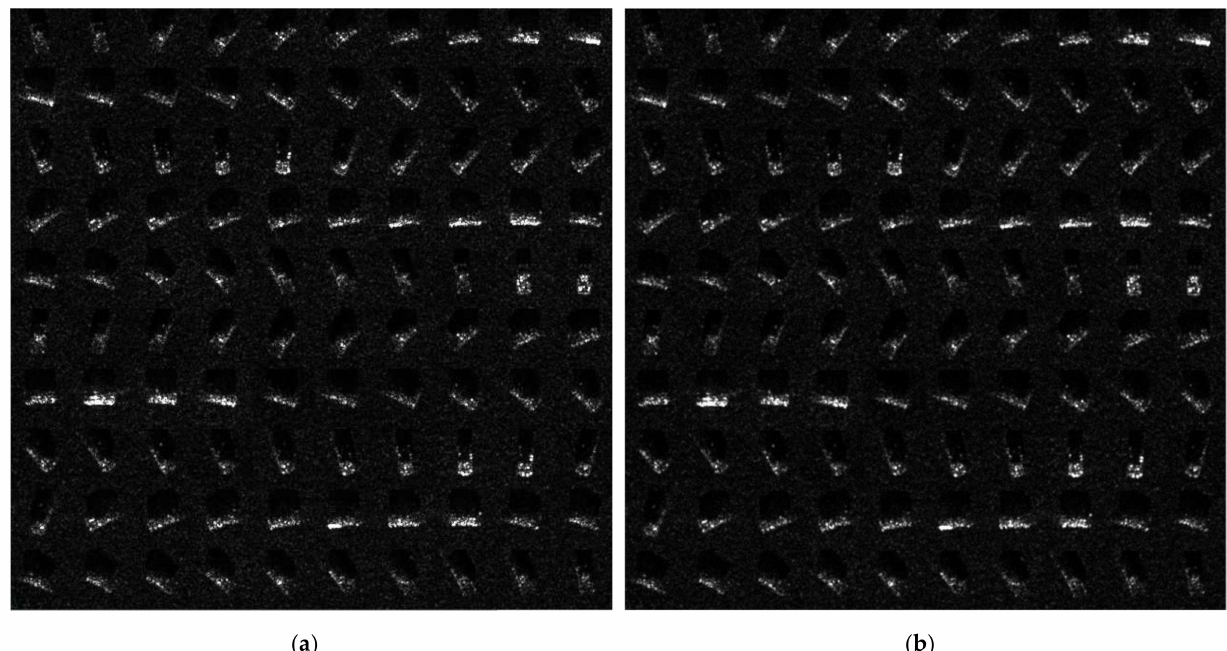
Figure 6. The comparison between D Peace and D17: ( a ) first 100 “BMP2”-class SAR images generated by PeaceGAN 17, GAN ( D Peace ) at pose angle increments with 5 ◦ ; ( b ) first original 100 “BMP2”-class SAR images from D17 at pose angle 17, GAN increments with 5 ◦